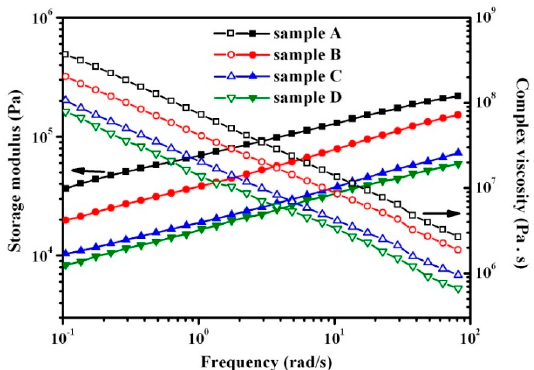
Figure 5. Storage modulus ( G’ ) and complex viscosity ( η * ) at 210 °C as a function of angular frequency for samples A to D.